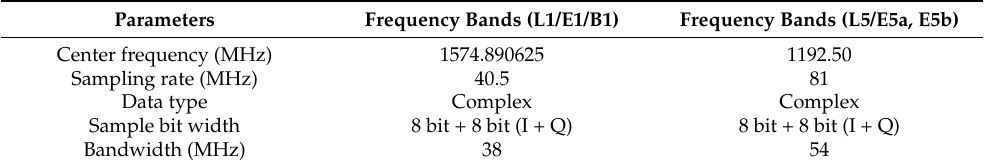
Table 2. Front-end configuration for TeleOrbit GTEC© dual-band GNSS signal receiver.